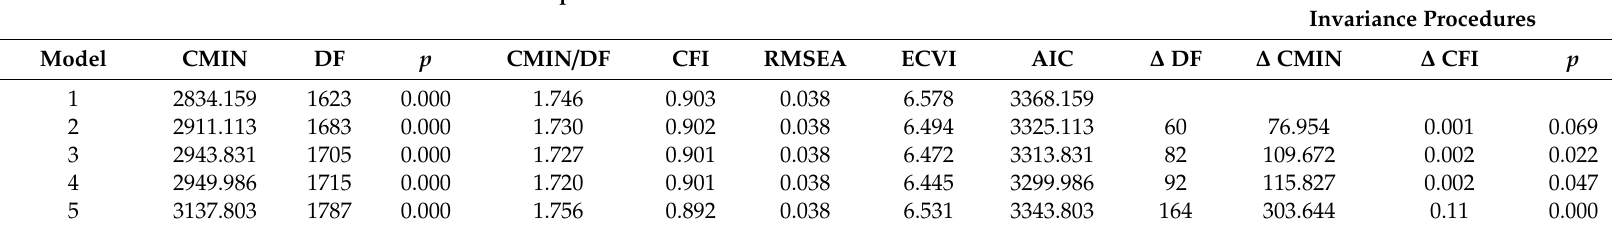
Table 3. Adjustment statistics for the models. Comparison between models using model 1 as the correct model. Goodness-of-fit Indices and Model Comparisons for Tested Models